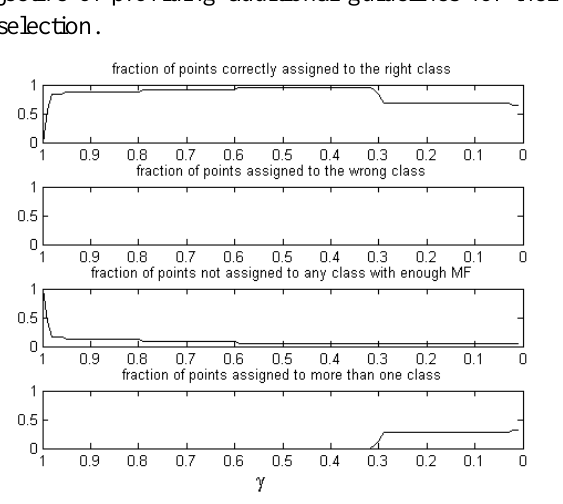
Fig. 16. Classification performance as a function of the confidence threshold